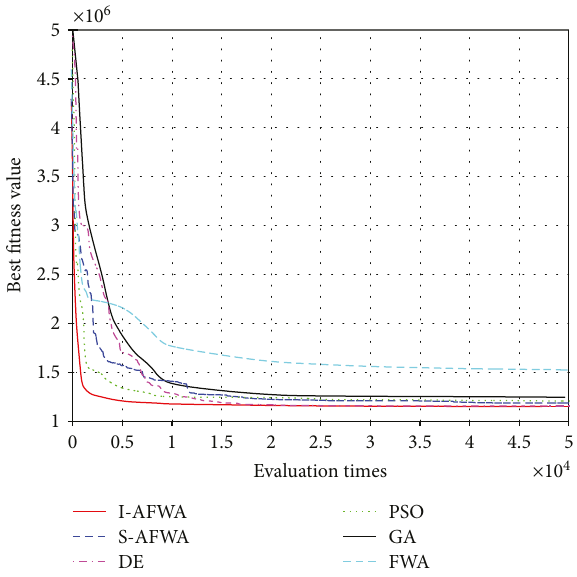
Figure 6: The average convergence curves of the fi tness function for each algorithm in minimum downrange reentry trajectory